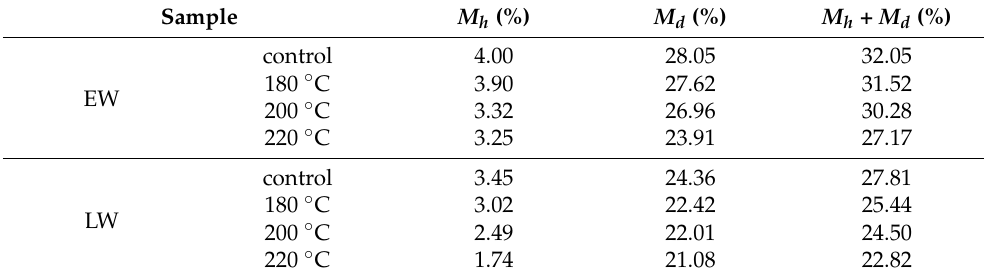
Table 2. M h and M d obtained from H-H fits projected to 100% RH.